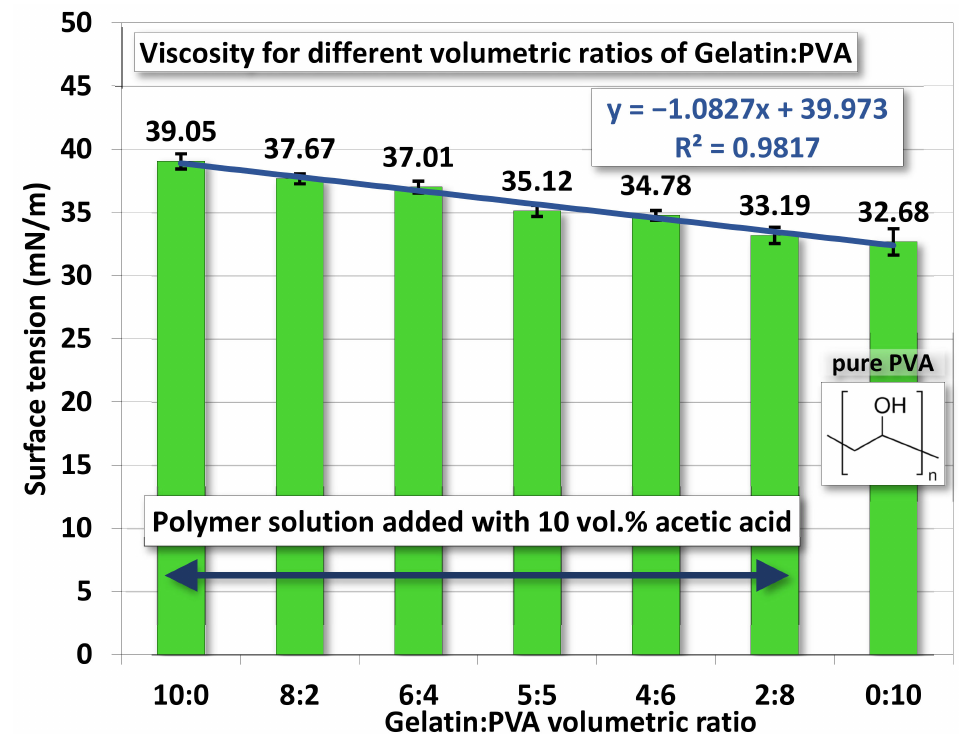
Figure 5. The average surface tension of gelatin/PVA mixed